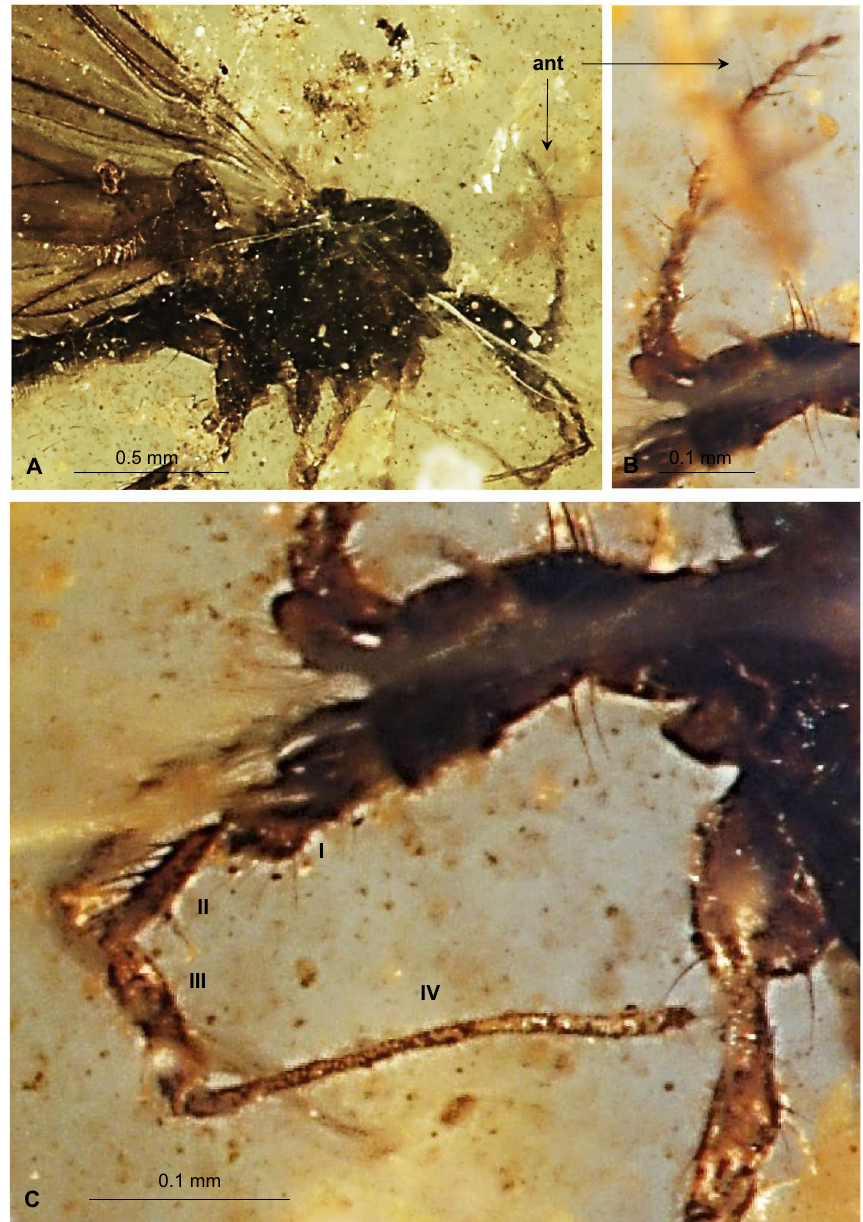
Figure 3. Gonomyia ( Iberiana ) penalveri subgen, et sp. nov. (Limoniidae), inclusions in Spanish amber: ( A ) head and thorax, lateral view; ( B ) antennae, lateral view; ( C ) palpi lateral